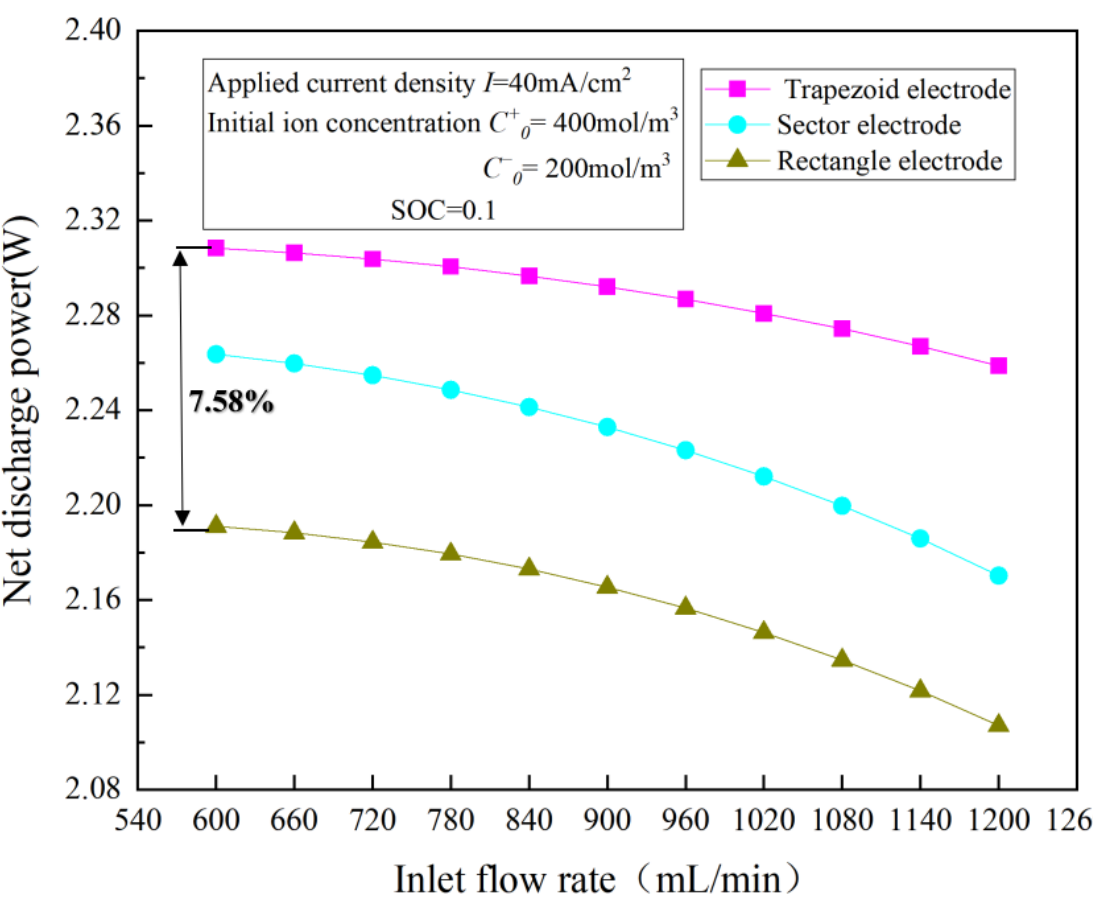
Figure 13. Variations in net discharge power with the electrolyte flow rates.